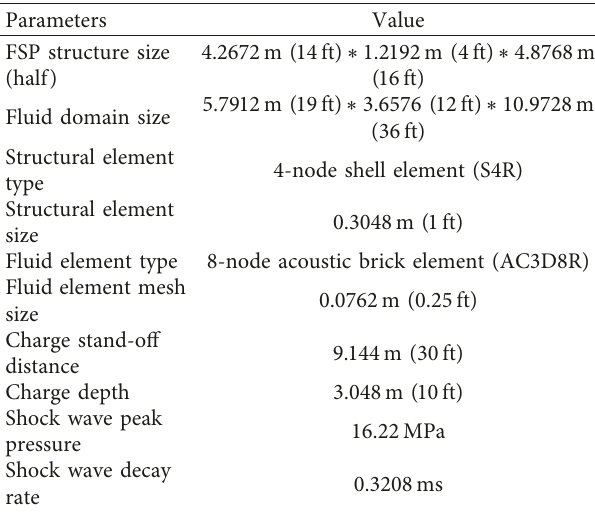
Figure 8: FSP Abaqus Table 2: Abaqus parameter configuration.